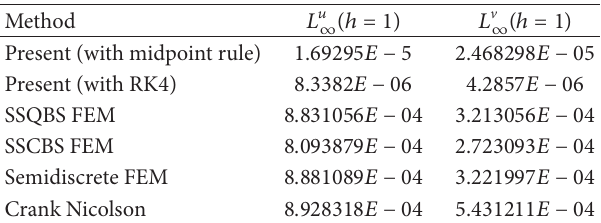
Table 5: The comparison of maximum errors using different schemes at 𝑡 = 0 .1 with 𝑘 = 0.0001